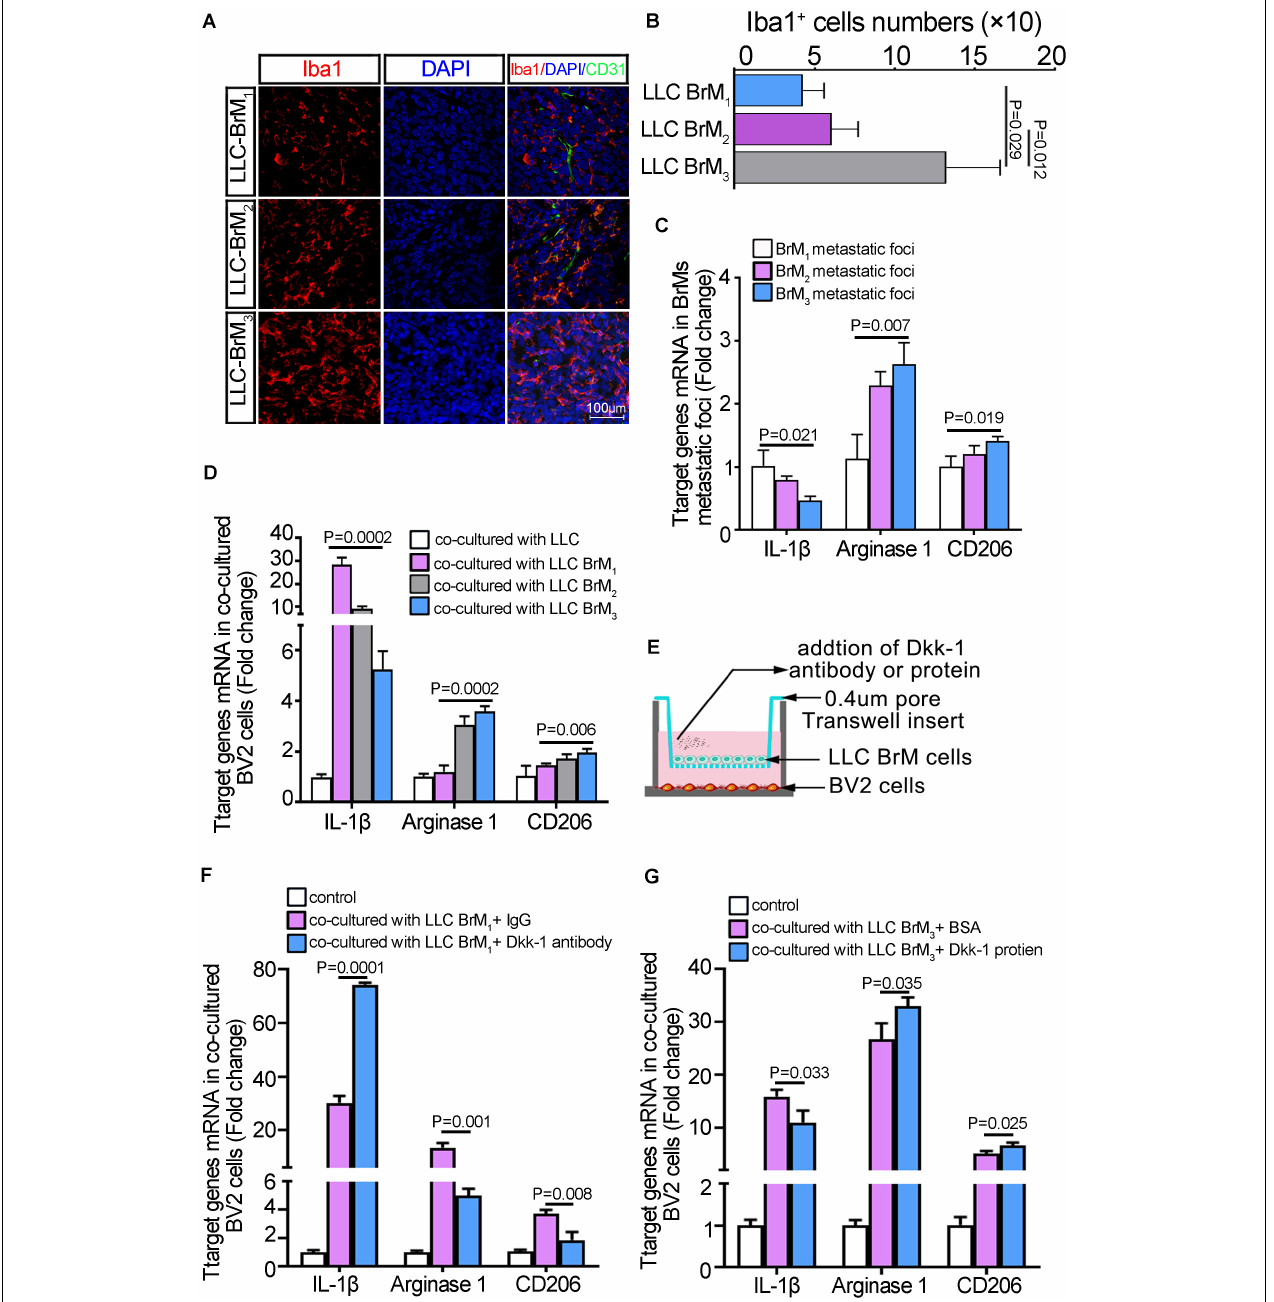
FIGURE 6 | The reduction of Dkk-1 in brain metastatic lung cancer cells was conducive to the phenotypic polarization of microglia in metastatic microenvironment. (A) The confocal microscopy images of immunofluorescence staining for Iba1 in the brain sections of LLC BrM cells-bearing mice. Scale bar, 100 µ m. (B) The quantitative analysis for the numbers of Iba-1-positive microglia cells in LLC BrM cells-bearing mice brain. The histograms represented the average numbers of Iba-1-positive microglia cells from the total 6 random visual fields in three independent experiments. (C) The qRT-PCR analyses for M1/M2-like markers in brain metastatic foci microdissected from the LLC BrMs-bearing mice. The results were presented as mean ± SD of three independent experiments. (D) The qRT-PCR analyses for M1/M2-like markers in BV2 cells co-cultured with LLC brain metastatic derivative cells. The results were presented as mean ± SD of three independent experiments. (E) Schematic illustration of the neutralized or rescued experiment through treatment with an anti-Dkk-1 antibody or a recombinant Dkk-1 protein, respectively. (F) The qRT-PCR analyses for M1/M2-like markers, IL-1 β , arginase-1 and CD206, in BV2 cells co-cultured with LLC BrM 1 cells as shown in (E) . The rabbit IgG was used as the control. The results were presented as mean ± SD of three independent experiments. (G) The qRT-PCR analyses for M1/M2-like markers, IL-1 β , arginase-1 and CD206, in BV2 cells co-cultured with LLC BrM 3 cells as shown in E. BSA was used as the control. The results were presented as mean ± SD of three independent